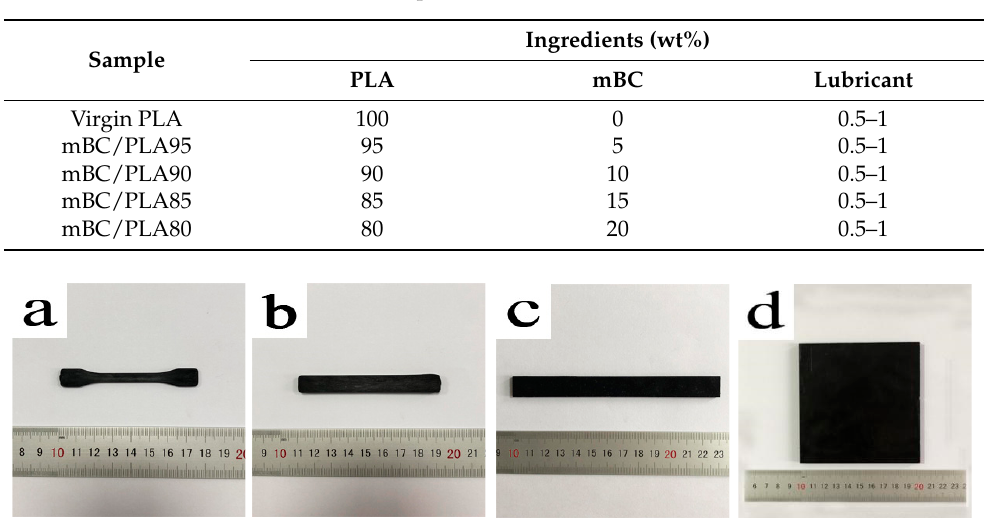
Figure 2. Sample images of PLA composites for measurements: tensile ( a ); flexural ( b ); LOI and UL-94 test ( c ) and CONE test ( d ).